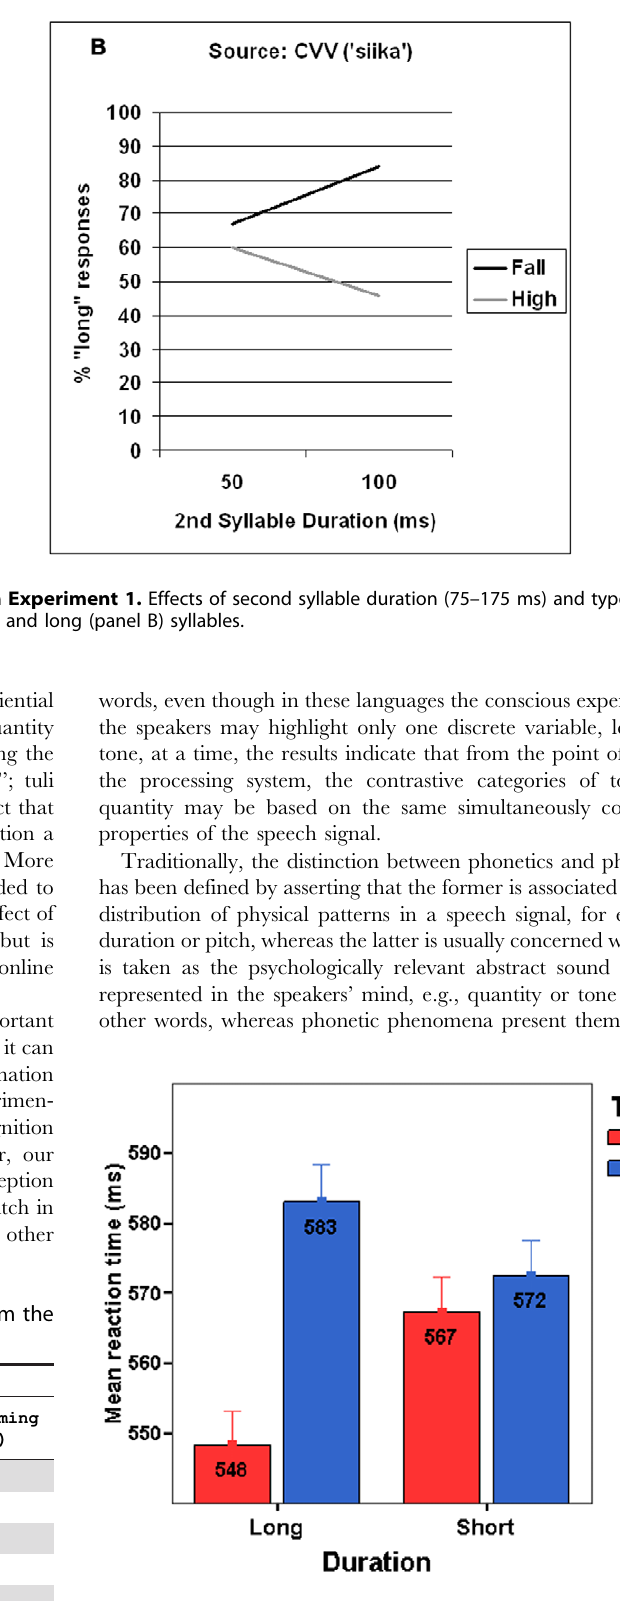
Figure 3. Mean reaction times in Experiment 2. Mean reaction times in milliseconds as a function of tone (high, fall) and duration (short, long) in Experiment 2. Error bars depict 95% CI.